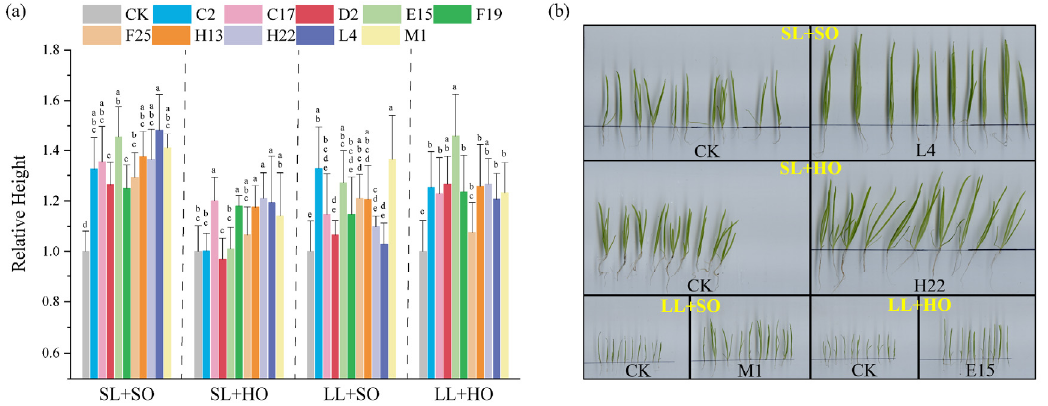
Figure 2. Relative shoot height of V. natans in different PGPR inoculation treatments ( a ). Morphological differences of V. natans with or without PGPR inoculation ( b ). CK: non-inoculation control; C2, C17, D2, E15, F19, F25, H13, H22, L4 and M1 present the inoculation treatments with the corresponding strains. Different letters indicate statistically significant differences ( p < 0.05, Univariate ANOVA). Ten replicates of each treatment were used for height measurement.